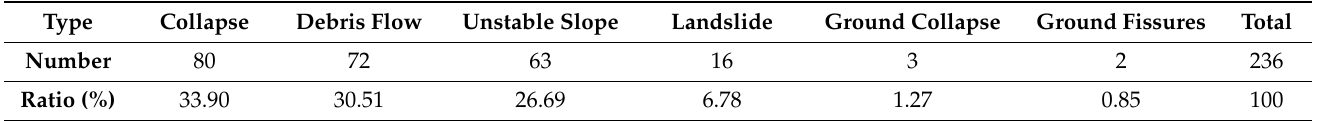
Table 1. List of geological hazards in the study